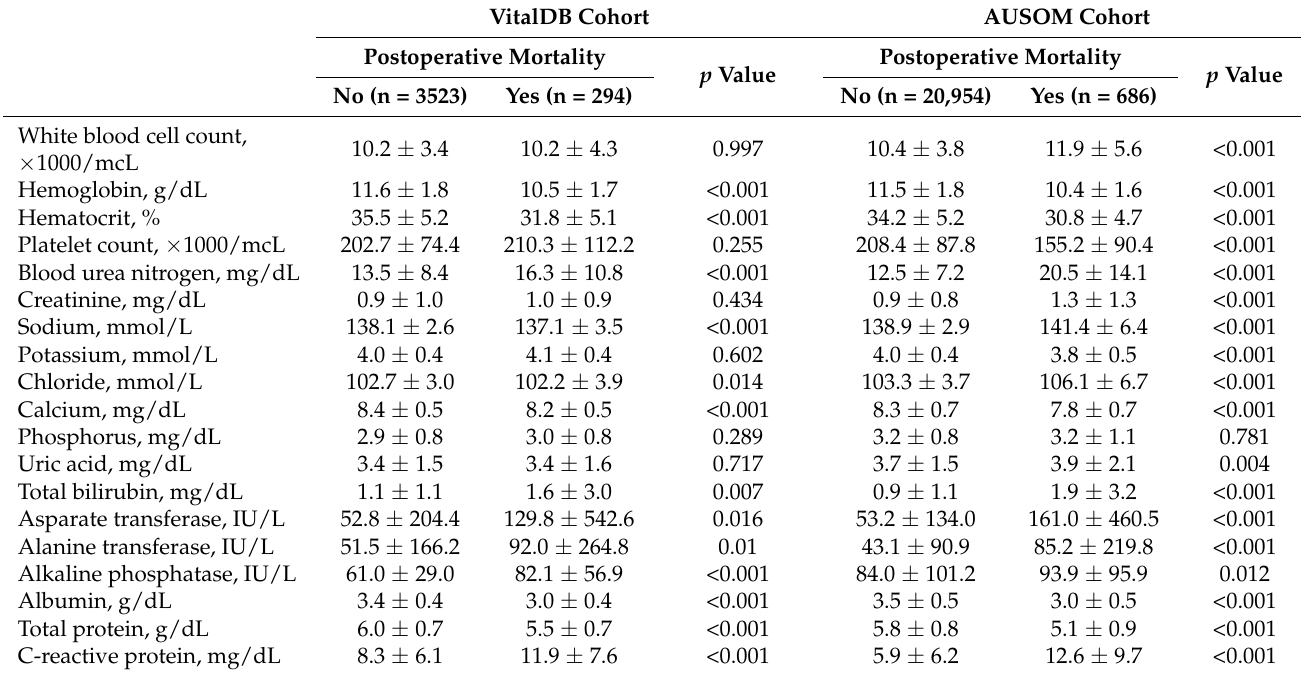
Table 2. Immediate routine postoperative laboratory values in patients with or without postoperative mortality. VitalDB Cohort AUSOM Cohort Postoperative Mortality Postoperative p Value